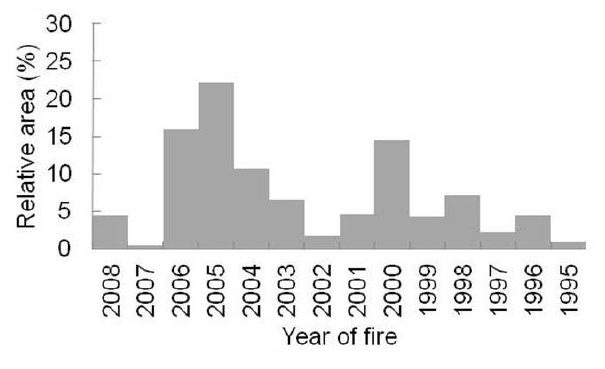
Fig. 8 . Relative area distribution of vegetation age classes from all transects from both sample years (2007 and 2008).